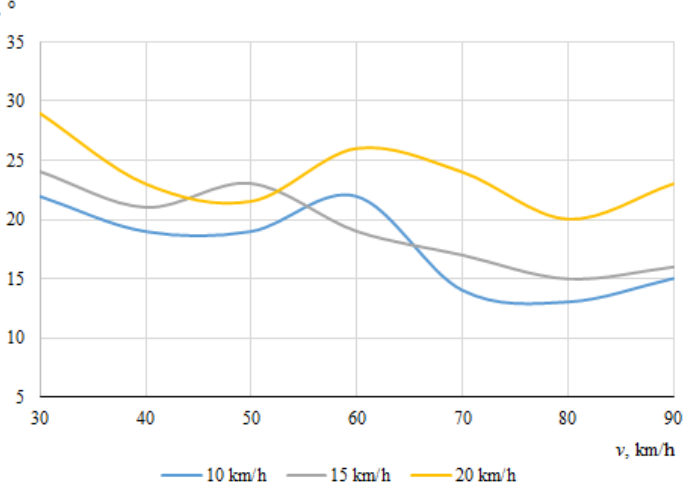
Figure 17. Cyclist throwing angle (impact angle 60°).